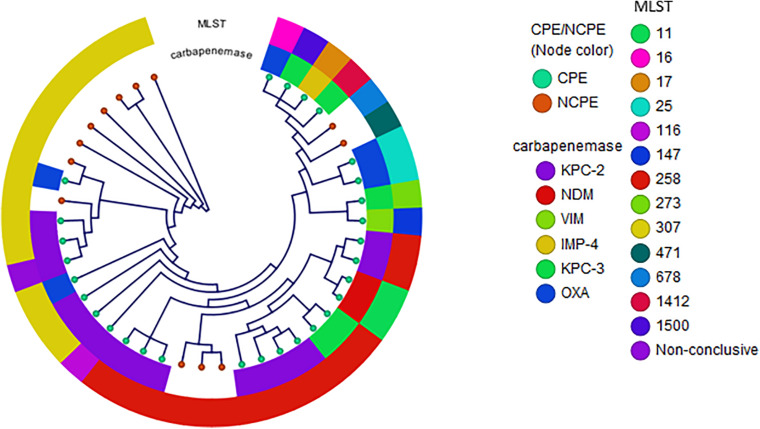
Phylogenetic reconstruction of K. pneumoniae. Distribution of isolates using SNP-based core genome alignments. Node color indicates CPE or NCPE. Layer 1 shows carbapenemase types. Layer 2 shows clonal groups by MLST.